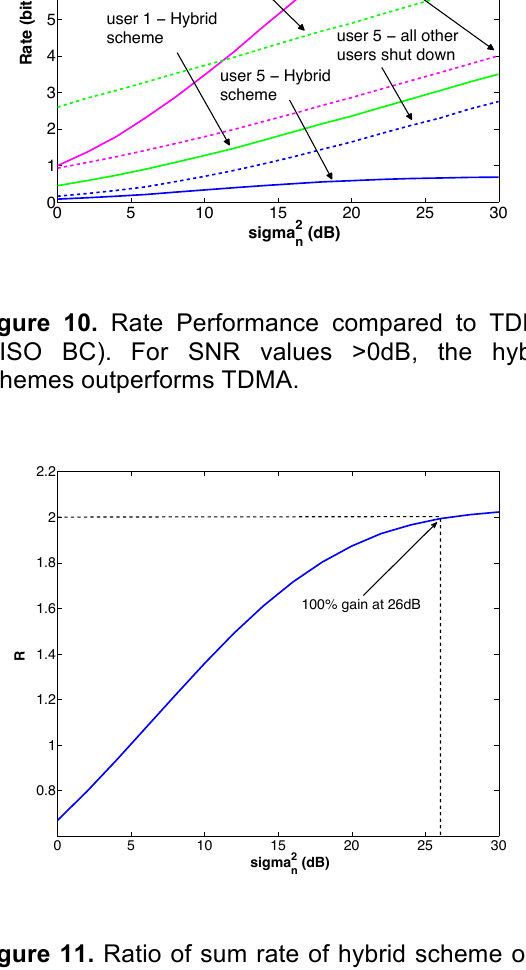
Figure 11. Ratio of sum rate of hybrid scheme over sum rate of TDMA (MIMO BC). For SNR values >26dB, the employment of the hybrid scheme provides 100% gain over